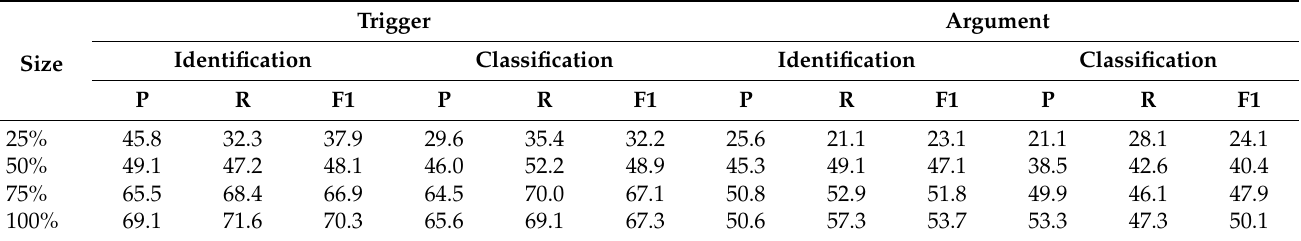
Table 5. Influence of dataset